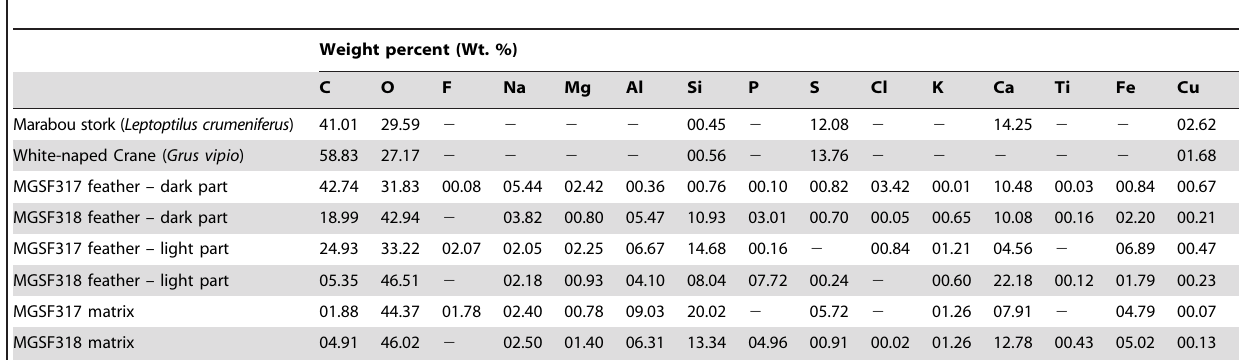
Table 1. EDS determined elemental composition of extant and fossil samples show in weight percent.